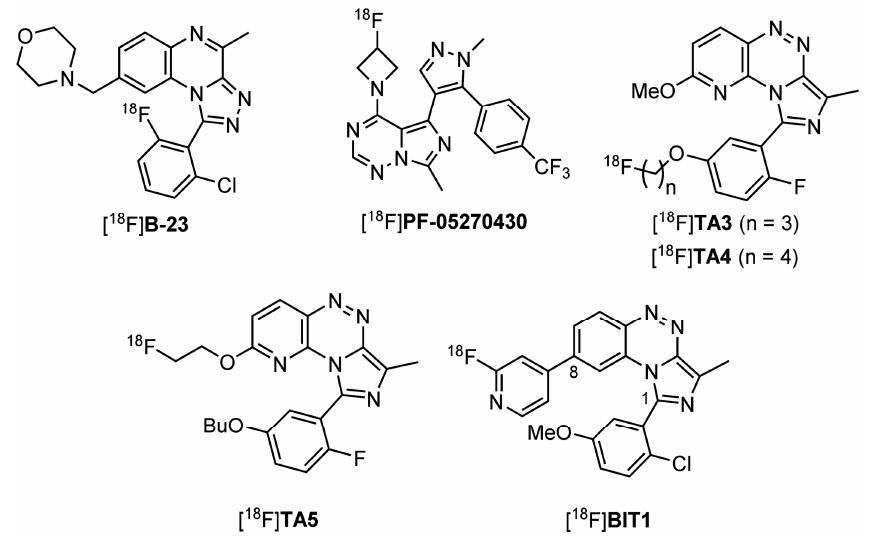
Figure 1. Selected phosphodiesterase 2A (PDE2A) PET radioligands [10,19,20,23–25].